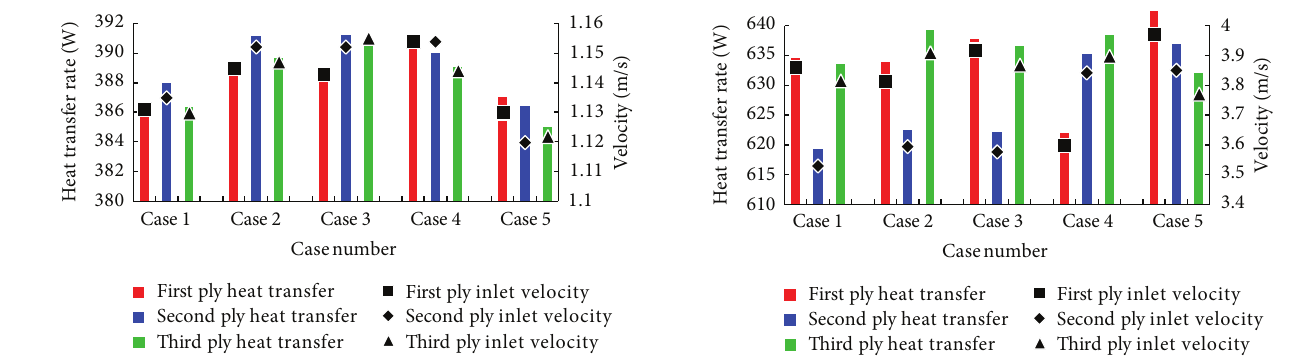
Figure 6: Variation of heat transfer rate with respect to inlet velocity at 10L/min in various